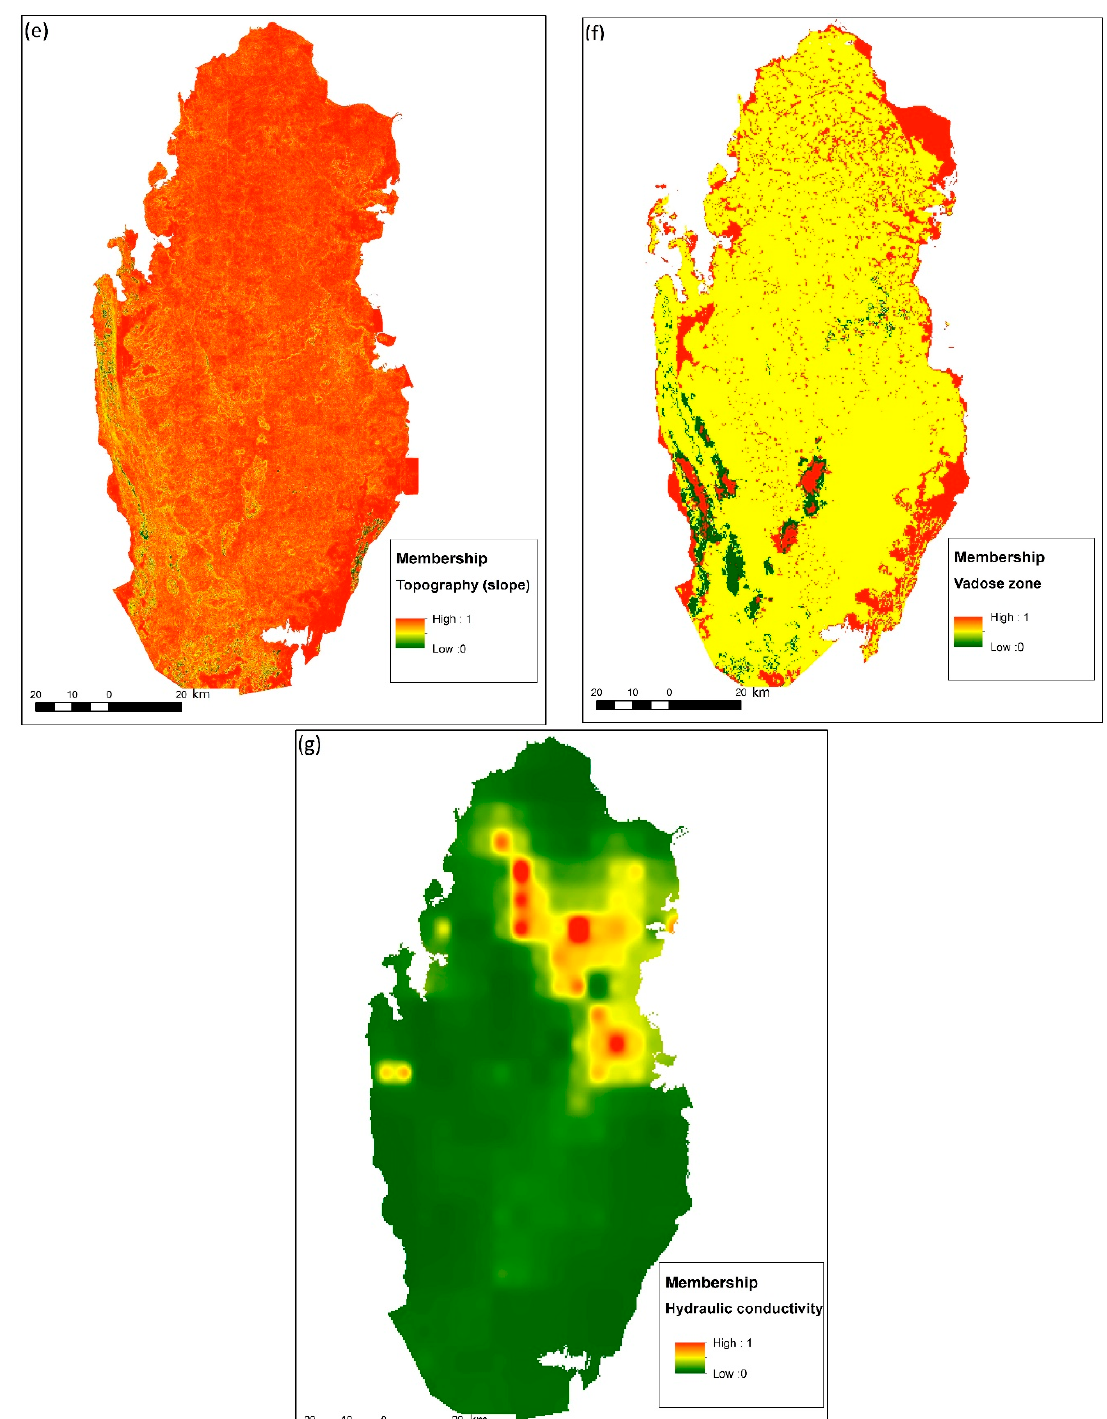
Figure 3: Fuzzified variables of DRASTIC approach. ( a ) depth to water table, ( b ) recharge, ( c ) aquifer media, ( d ) soil media, ( e ) slope, ( f ) vadose zone, and ( g ) hydraulic conductivity.